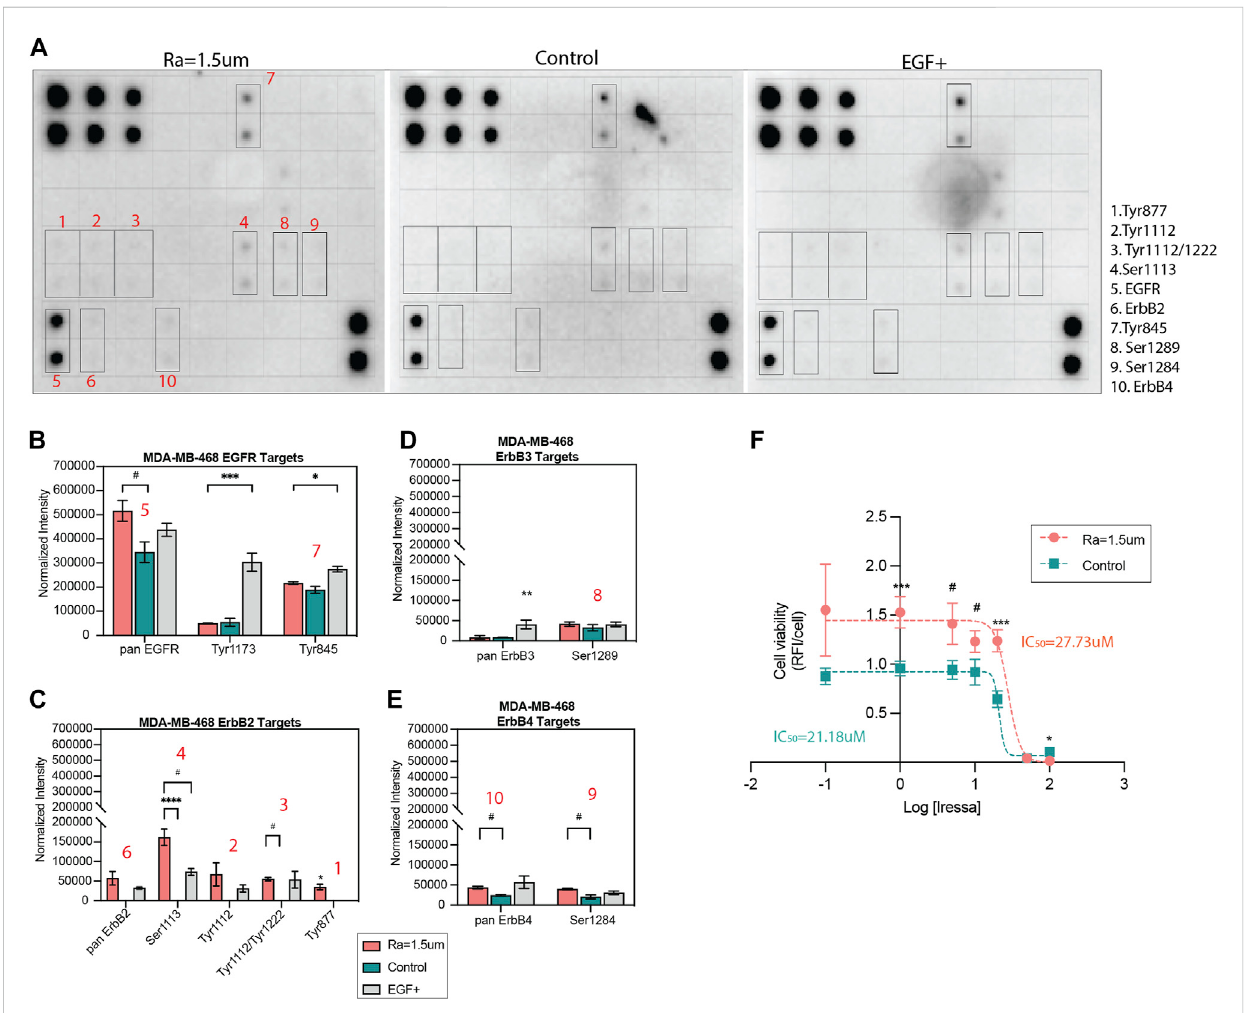
FIGURE 5 EGFR phosphorylation patterns and drug inhibition are altered by surface roughness in MDA-MB-468. (A) hEGFR phosphorylation micrographs of TNBC cells cultured for 5 days in reduced serum (2% FBS) on surfaces with roughness of Ra = 1.5 µm, TCP surface as a standard control or TCP surface supplemented with 10 ng/mL EGF as a positive control. The array includes 17 phospho-proteins of the pan EGFR, ErbB-2, ErbB-3, ErbB-4 receptors (identi fi ed in Supplementary Figure S6). Blots with increased expression are identi fi ed and numbered in red. (B – E) Quanti fi cation of the phosphorylation of pan EGFR, ErbB-2, ErbB-3, ErbB-4 and their corresponding phospho-proteins, depicted as the normalized intensity relative to assay positive controls. (F) EGFR inhibition-response curve of MDA-MB-468 cells cultured on surfaces with roughness Ra = 1.5 µm compared to TCP control. Error bars depict the mean ± SEM of 2-3 independent experiments with n = 2-3 samples. T -test with Mann-Whitney non-parametric test. Asterisk (*) represent p -values < 0.05, (**) p -values < 0.01, (***) p -values < 0.001 and (****) p -values < 0.0001, (#) p -values <